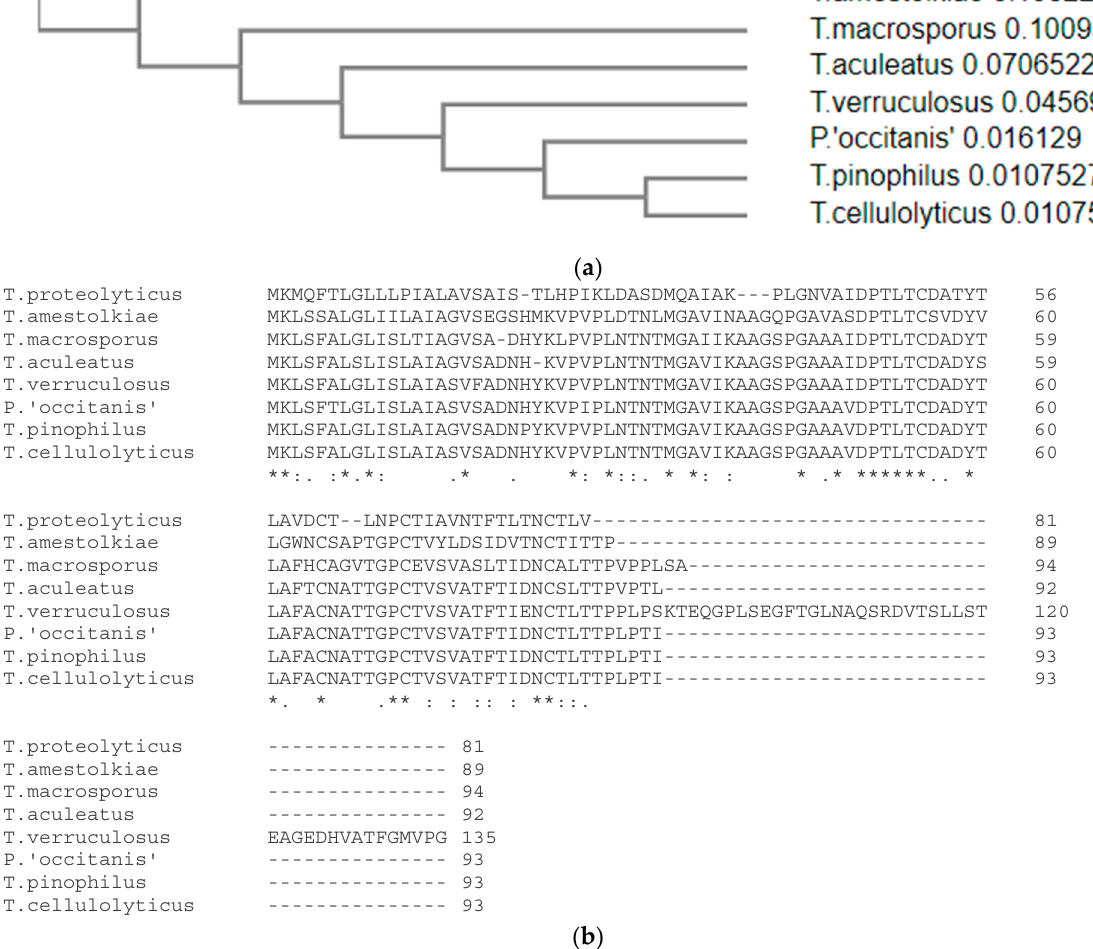
Figure 6. Putative ICARUS sequences in other Talaromyces species ( a ). Blast search of different genomes. ( b ) A similarity tree based on these sequences.